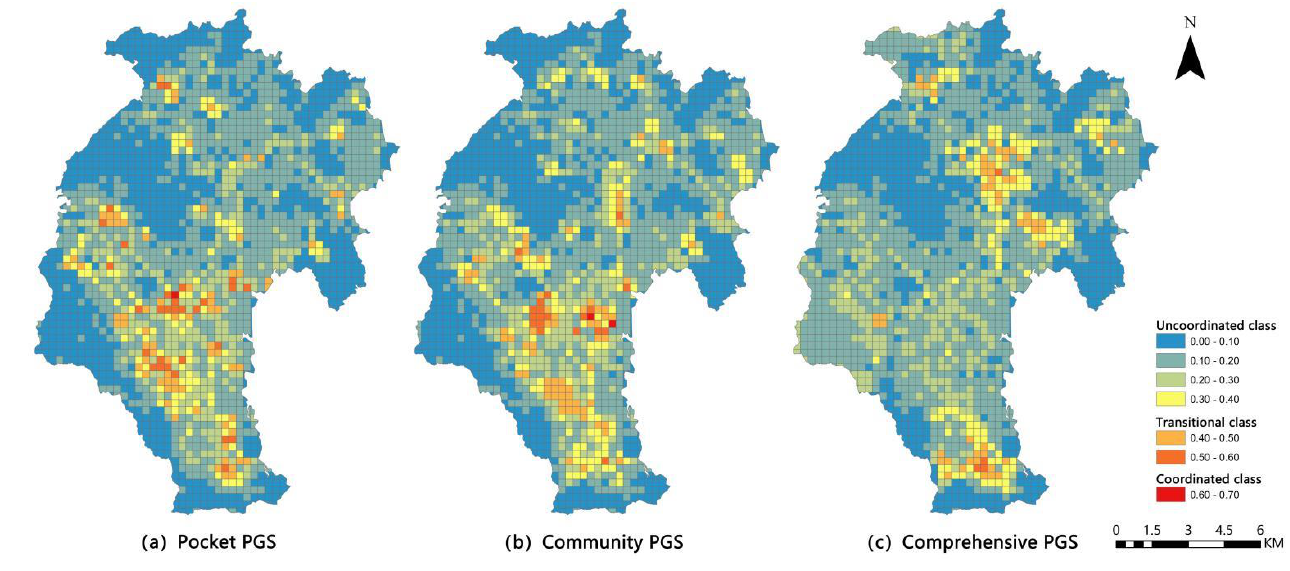
Figure 8. Spatial patterns of PGS-SED coupling coordination degree (CCD).